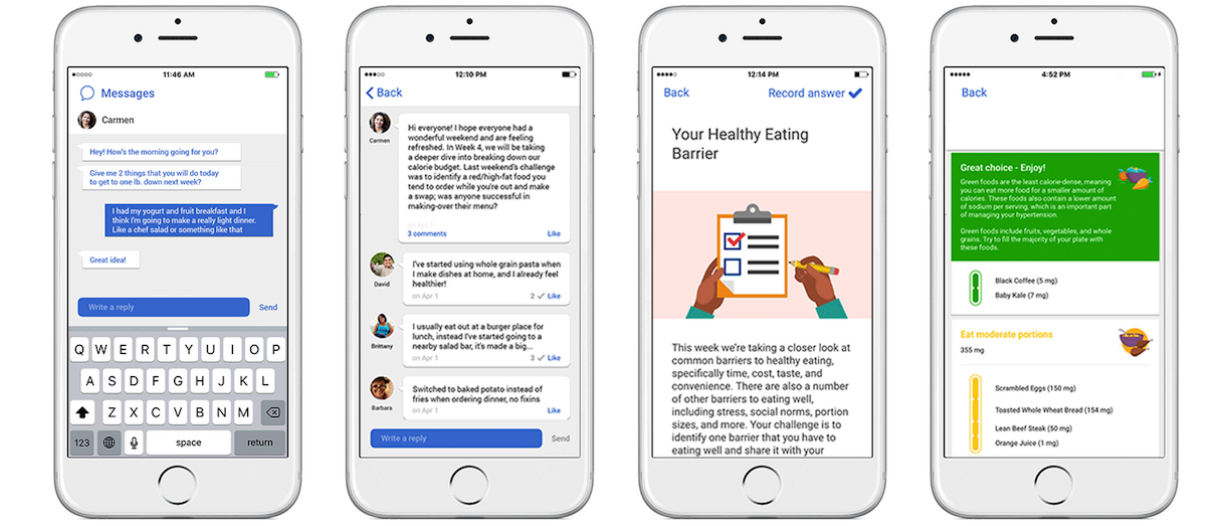
Figure 2. The Noom Coach app's interactive interface with coach-user messaging, group messaging, daily challenges, food logging with color coding and automated feedback based on food choices.